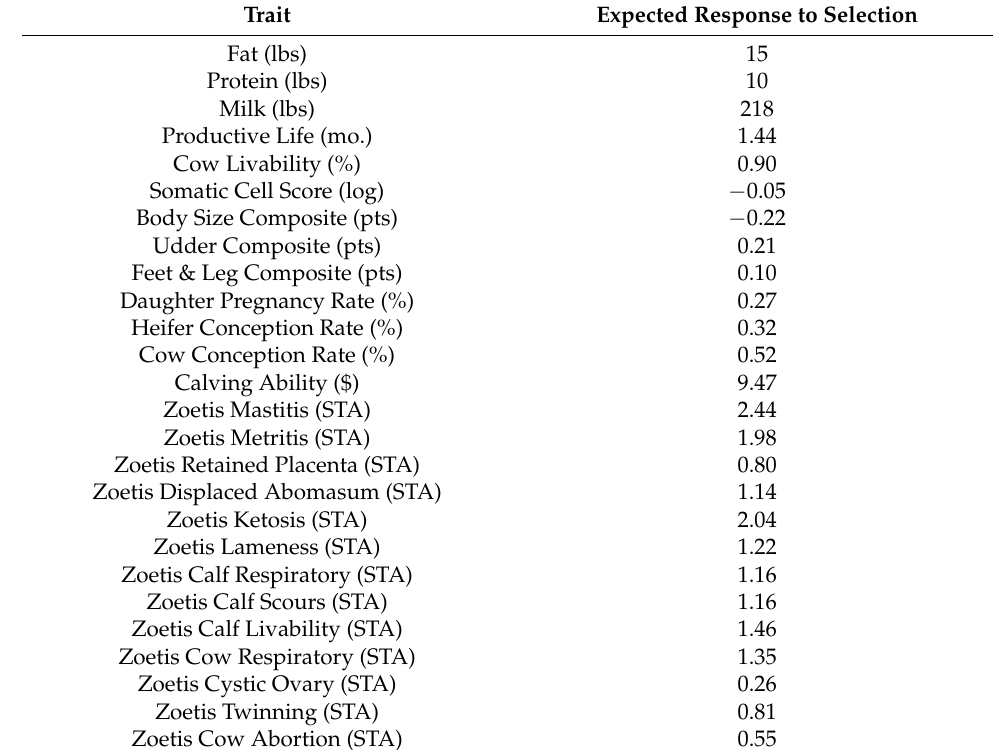
Table A1. Expected response to selection expressed in units of the underlying trait when average Table